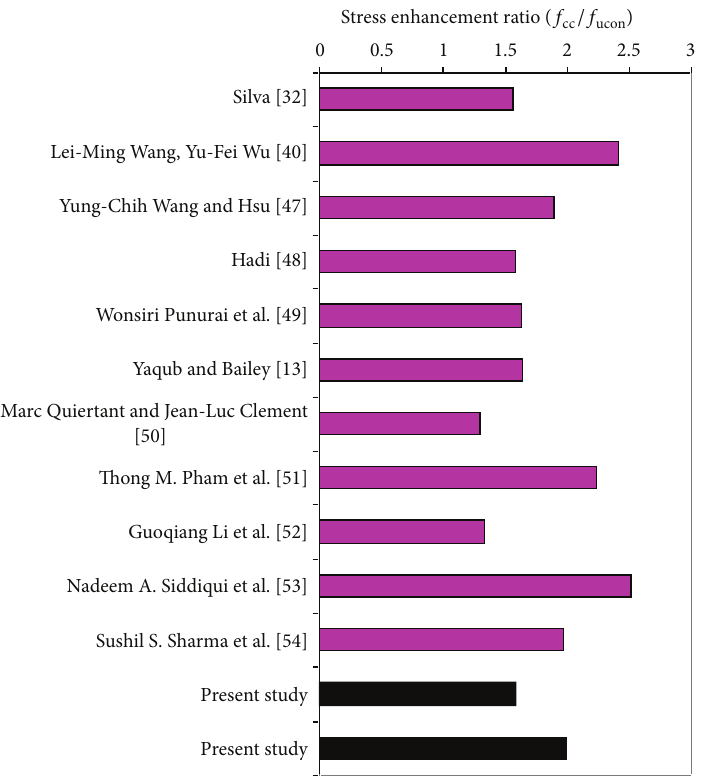
Figure 21: Strength enhancement ratio of present and previous studies,